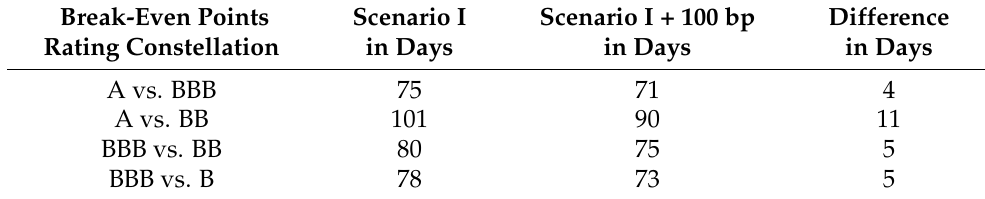
Table 5. Summary of break-even